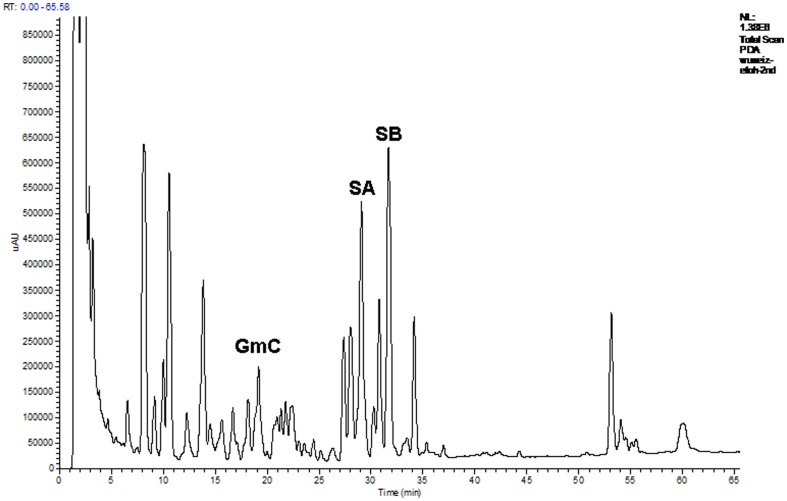
Spectral characterization of the peptidoglycan SC-2 isolated a from S. chinensis fruits.The absorption at 490(A). Purity identification of SC-2 obtained from the fractions 33–39 obtained by Sephadex G-100 column by high-performance size exclusion chromatography (HPSEC) with a PolySep GFC P-4000 column (300×7.8 mm) with water as eluant at a flow rate of 0.8 ml/min (B). The FTIR spectrum of purified SC-2. C (C): And the X-ray powder diffraction pattern of SC-2 (D).